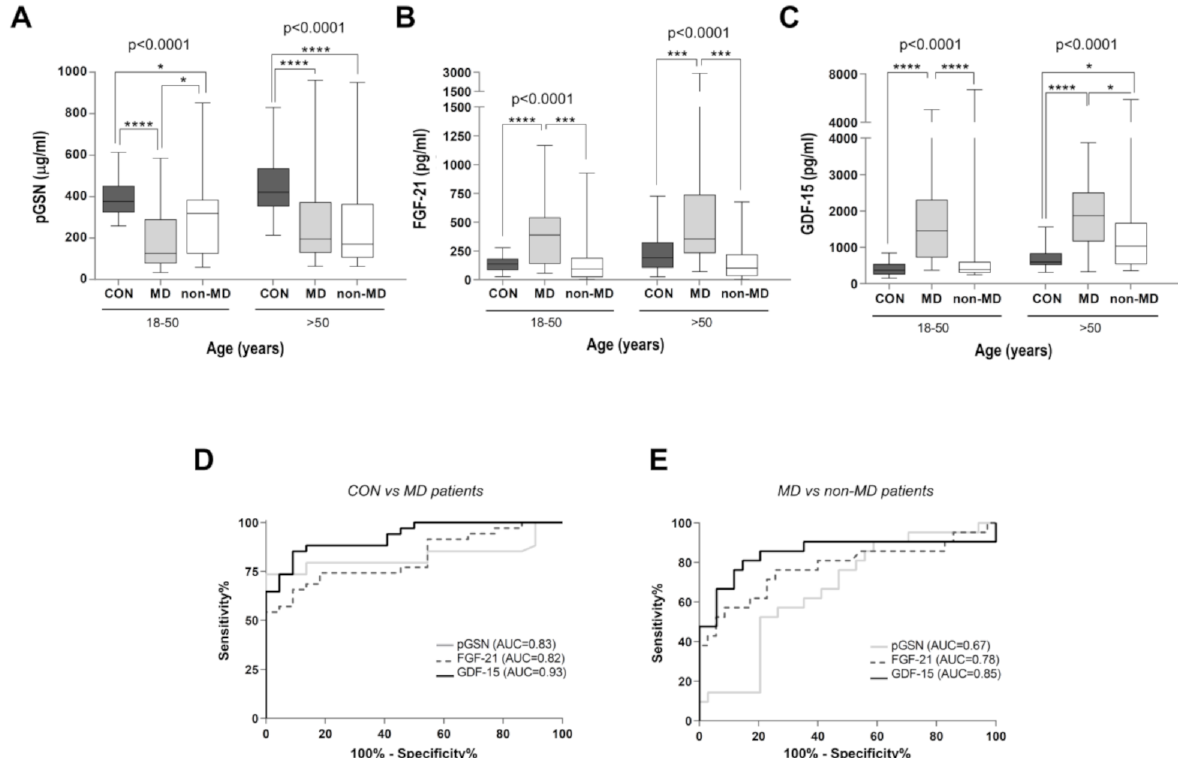
Figure 3. Average plasma concentrations of pGSN, FGF-2, and GDF-15 according to age. For ( A – C ): Average concentrations of pGSN ( B ), FGF-21 ( C ), and GDF-15 ( D ) in controls (CON, n = 56), MD patients ( n = 60), and non-MD patients ( n = 41) based on their age ranges (either between 18–50 yrs, or >50 yrs). Data are presented as the median, interquartile range, minimum, and maximum. Kruskal–Wallis test p -values for the two groups (subjects between 18 and 50 and >50 yrs old) are indicated on top of the figures. Post hoc Mann–Whitney U test p -values: **** p < 0.00001, *** p < 0.0001, * p < 0.05. For ( D , E ): Comparative ROC curves for pGSN, FGF-21, and GDF-15 in the young study cohorts (subjects between 18 and 50 yrs). ( D ) ROC curve in MD patients vs. healthy controls. AUC values were 0.83 for pGSN (CI: 0.71–0.94), 0.82 for FGF-21 (CI: 0.71–0.93), and 0.93 for GDF-15 (CI: 0.86–0.99). ( E ) ROC curve in MD patients vs. non-MD patients. AUC values were 0.67 for pGSN (CI: 0.52–0.81), 0.78 for FGF-21 (CI: 0.64–0.92), and 0.85 for GDF-15 (CI: 0.72–0.98). AUC = area under the curve; ROC = receiver operating characteristic; CI: confidence